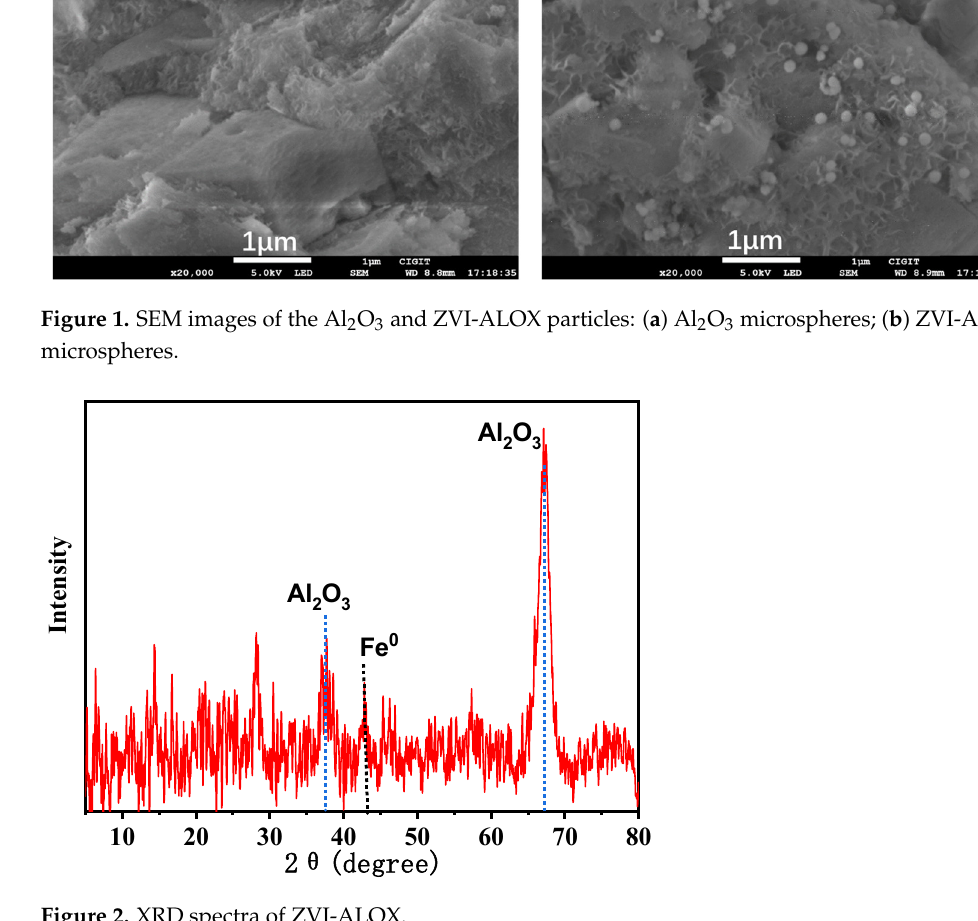
Figure 2. XRD spectra of ZVI-ALOX.